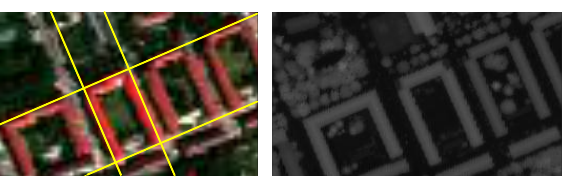
Figure 5: Building boundary approximation (left, yellow lines), and comparison of size with laser DSM (right).